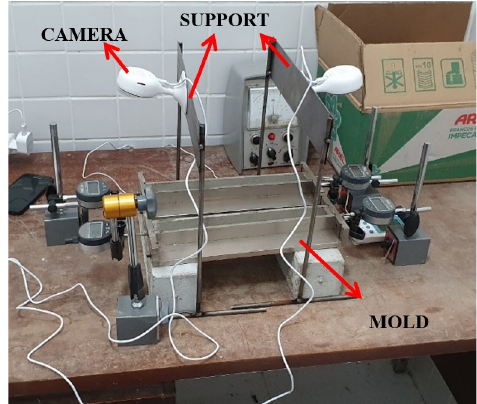
Figure 7. Cameras and their supports.